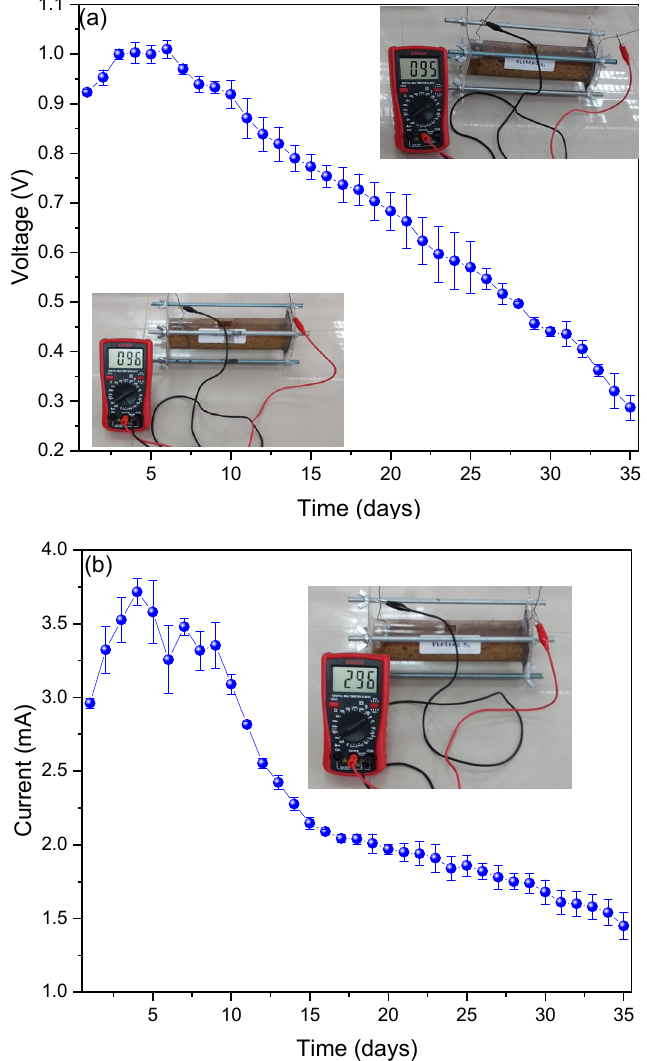
Figure 2. Values of ( a ) voltage and ( b ) electrical current monitored from microbial fuel cells.